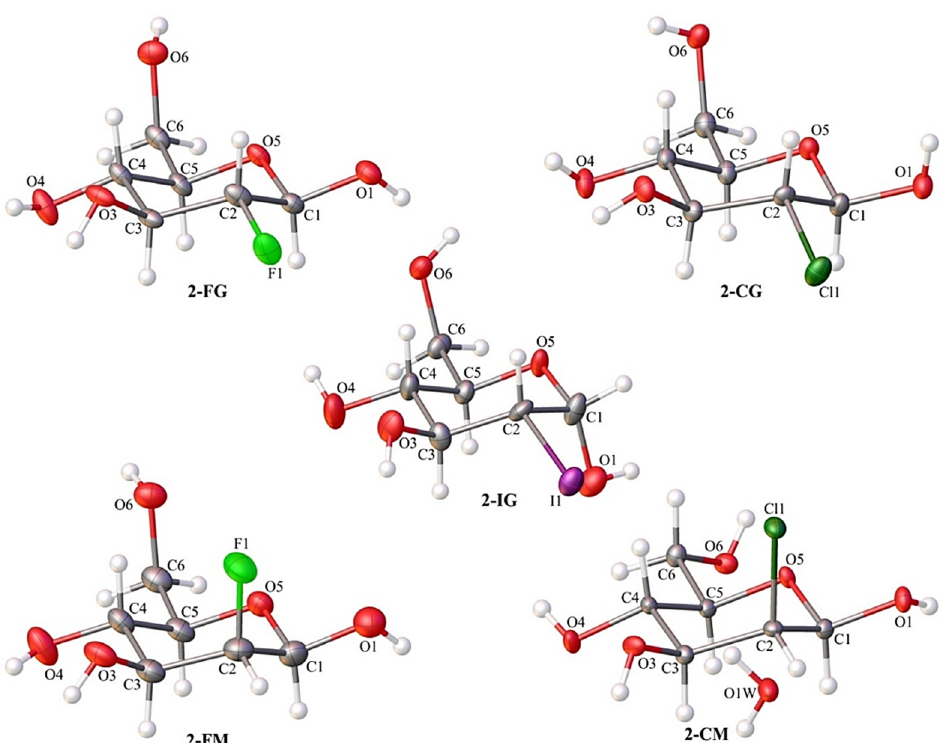
Figure 2. The content of the asymmetric unit of the crystal structures of investigated compounds with the atom numbering scheme. Atomic displacement ellipsoids are shown with 50% probability and the H-atoms are shown as small spheres of arbitrary radius.